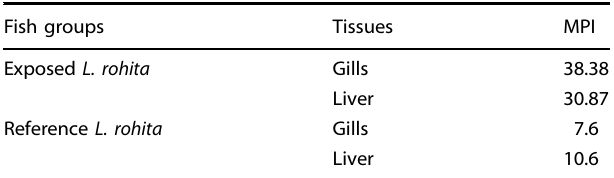
Table 2. MPI calculation in exposed and reference fi